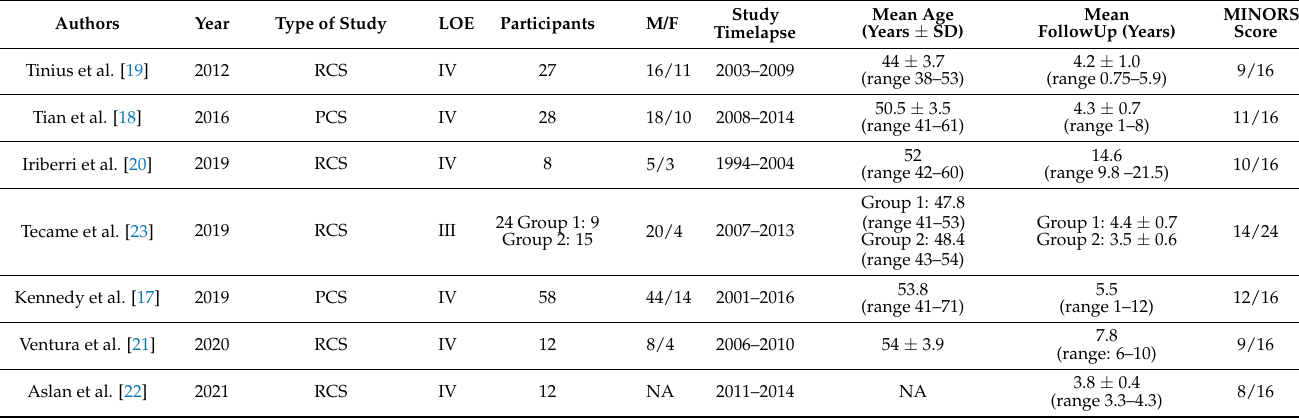
Table 1. Study characteristics, demographic details and Methodological Index for Non-randomized (MINORS)